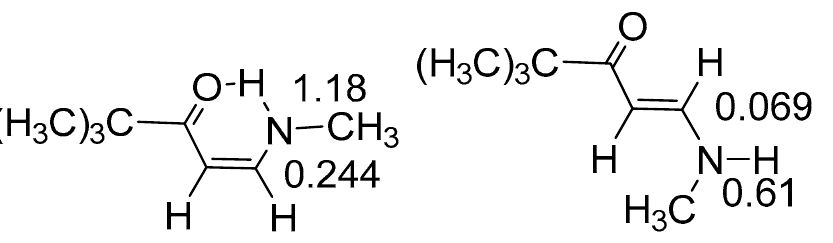
Figure 20. One ‐ bond deuterium isotope effects on 15 N chemical shifts and two ‐ bond deuterium Figure 20. One-bond deuterium isotope effects on 15 N chemical shifts and two-bond deuterium isotope effects at carbon in ppm. From [76]. isotope effects at carbon in ppm. From [76].